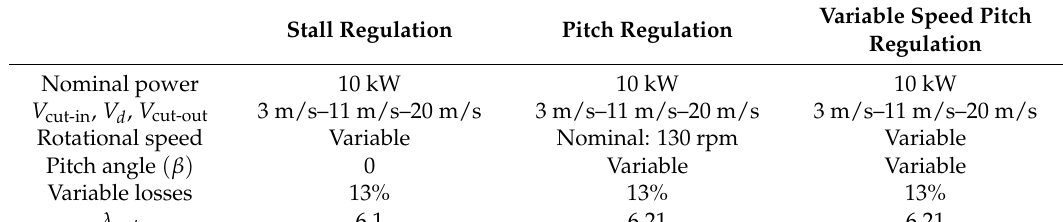
Table 3. Operational characteristics of the three wind turbine designs studied in this work.